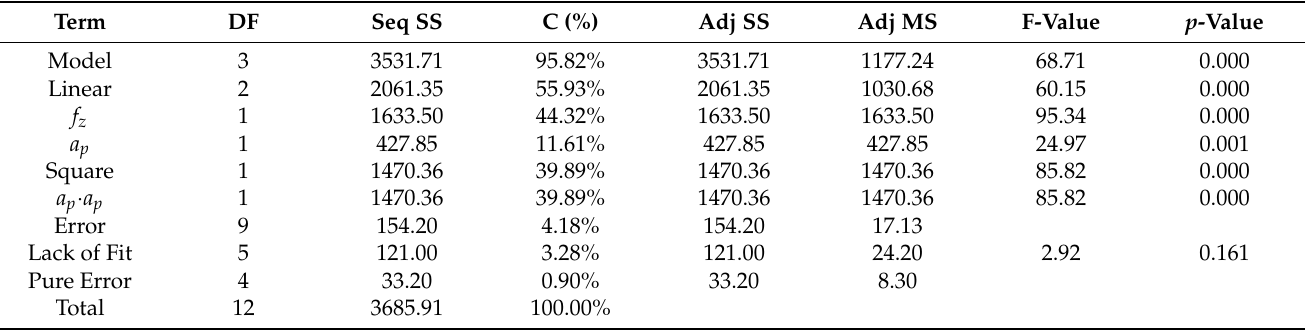
Figure 14. Surface roughness RSm parameter model. Table 9. Analysis of variance for the RSm surface roughness model.